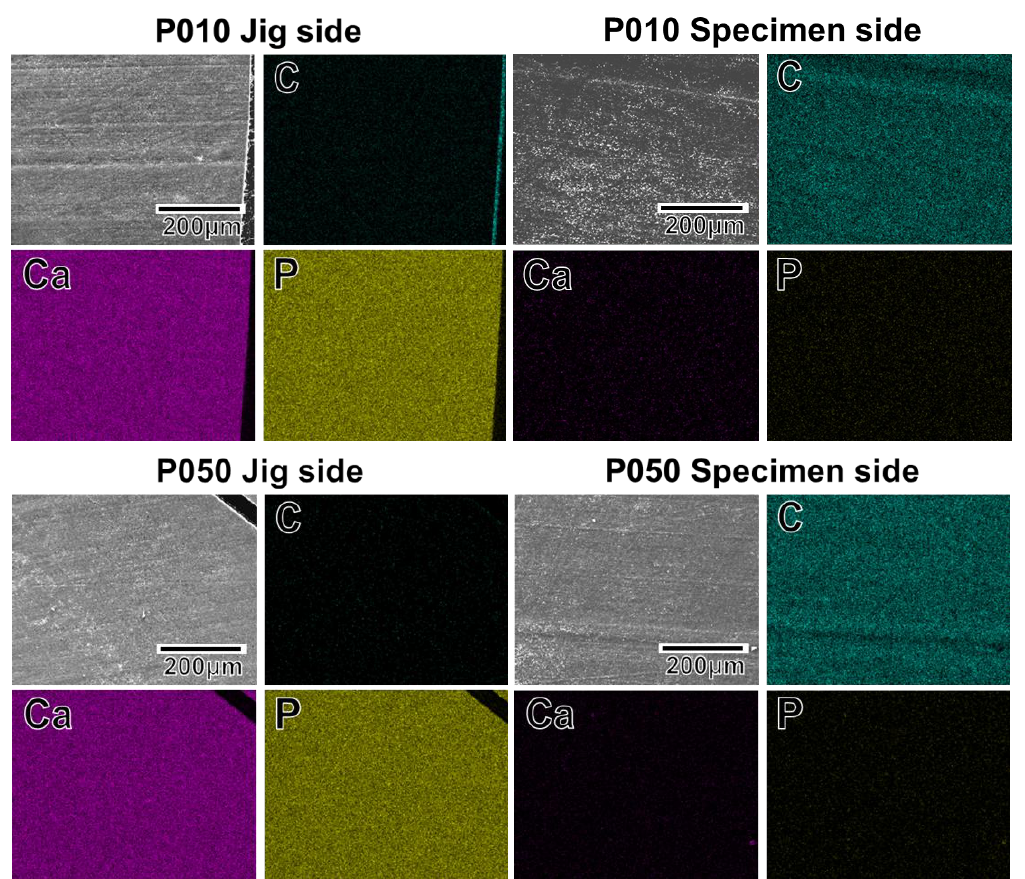
Figure 8. SEM (upper left image in a set of 4 images) and EDX (C, Ca, P) images of the specimen side and jig side fractured surfaces, after the measurement of adhesion strength of the apatite coatings to the surfaces of the plate specimens P010, P050, and